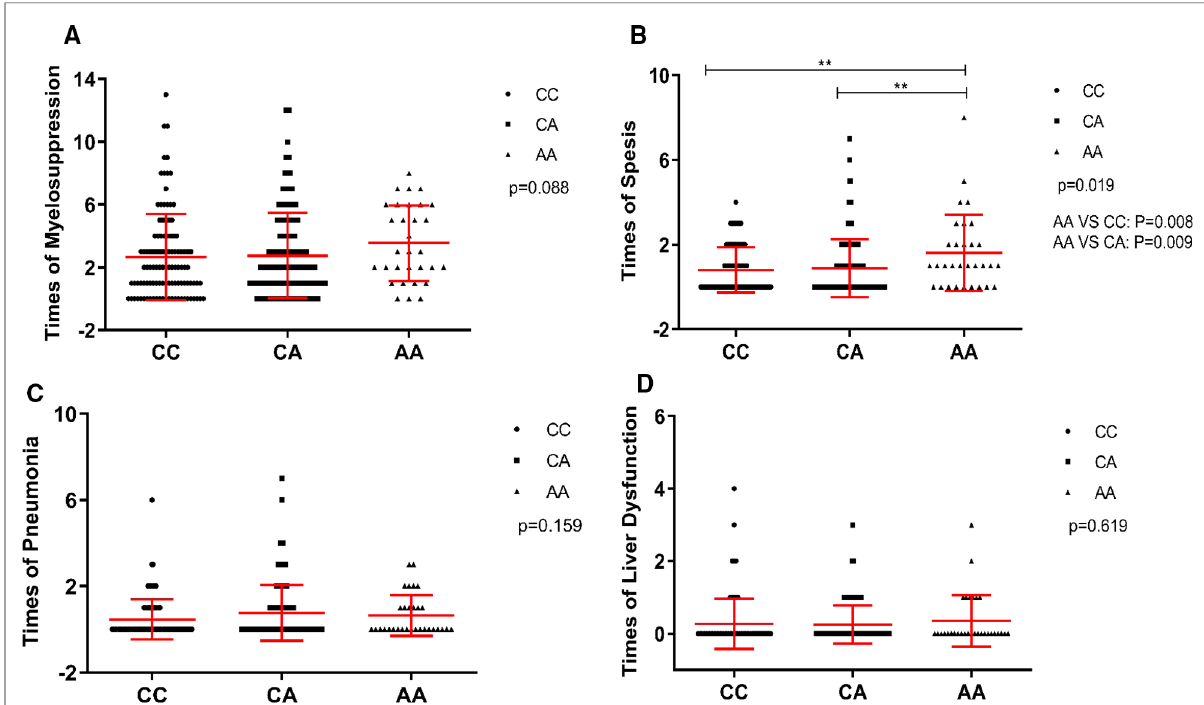
FIGURE 3 Association of times of myelosuppression ( A ), sepsis ( B ), pneumonia ( C ), and liver dysfunction ( D ) with genotype at rs3824662 in CCLG-2008 protocol, with P -values estimated by Kruskal-Wallis test. Indicating that the GATA3 SNP rs3824662 genotype has sepsis